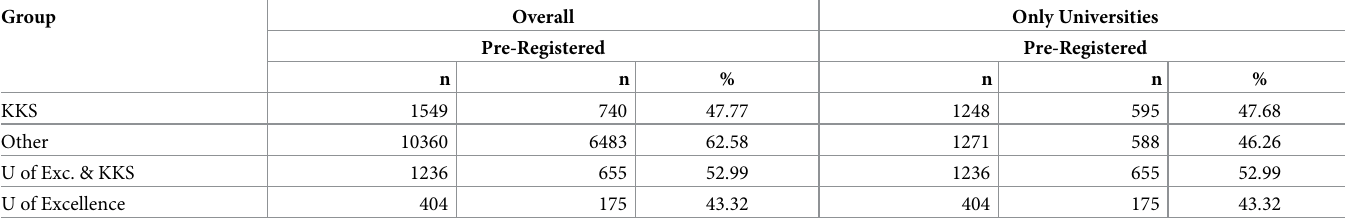
Table 7. Number and percent of Pre-Registered studies depending on status as university of excellence and on presence of a coordinating center for clinical studies. Trials that were registered between 2007 and 2013. Group